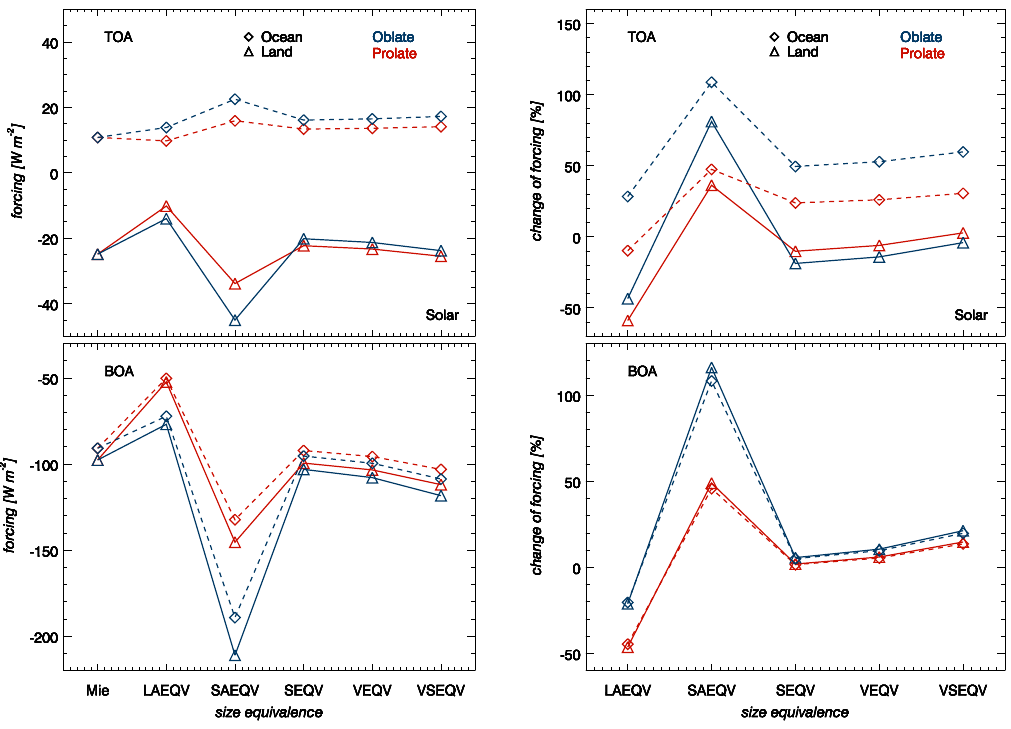
Fig. 15. Simulated solar forcings of Saharan mineral dust (left) and changes of forcing caused by spheroidal particles compared to sphercial ones (right) at the TOA (top) and BOA (bottom) over a mean land and ocean surface. See main text for details.